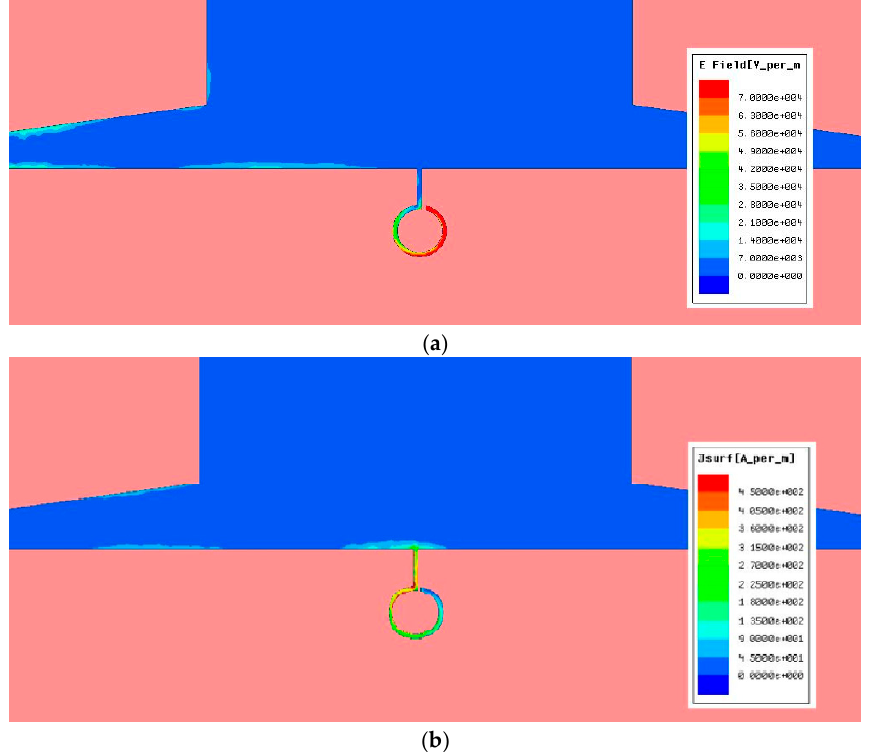
Figure 10. Distribution of the electric field ( a ) and current ( b ) for the HMSIW structure loaded with an ORR at the resonant frequency f 0 = 3.49 GHz.